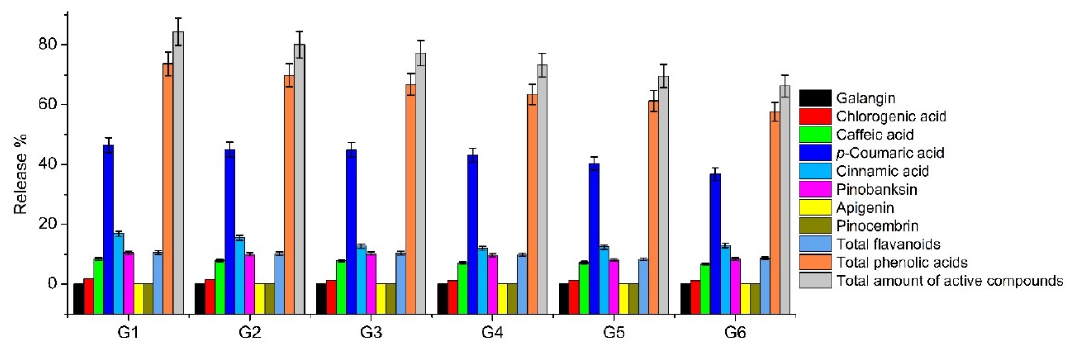
Figure 7. Percentage amounts of active compounds released after 8 h in experimental in situ gels G1–G6 (mean ± SD, n = 3).